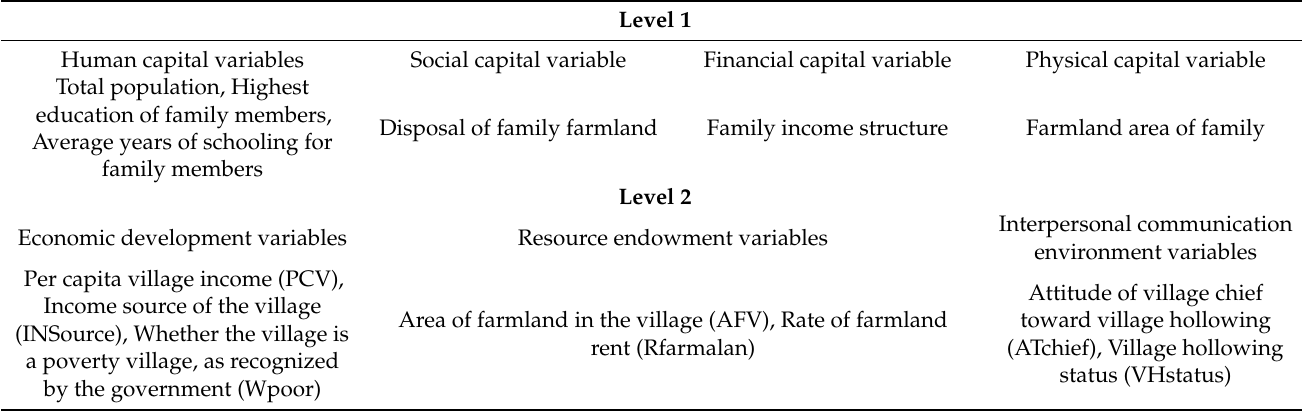
Table 3. Variables in the HLM.